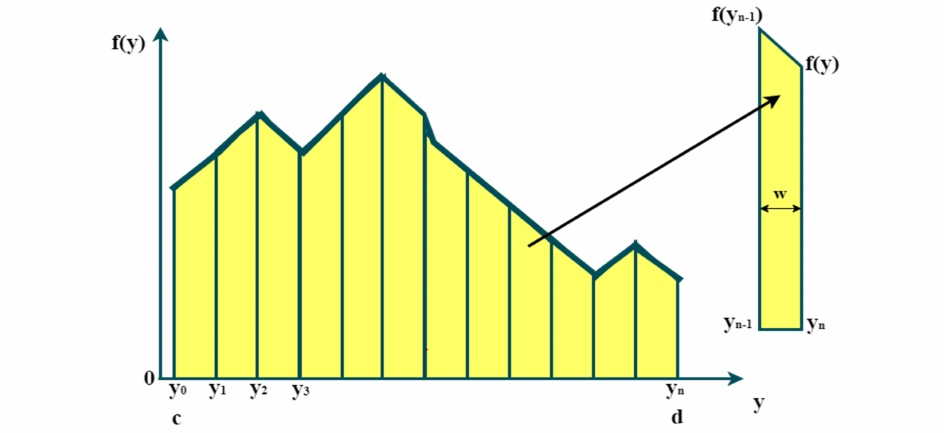
Figure 6. Concept of the trapezoidal